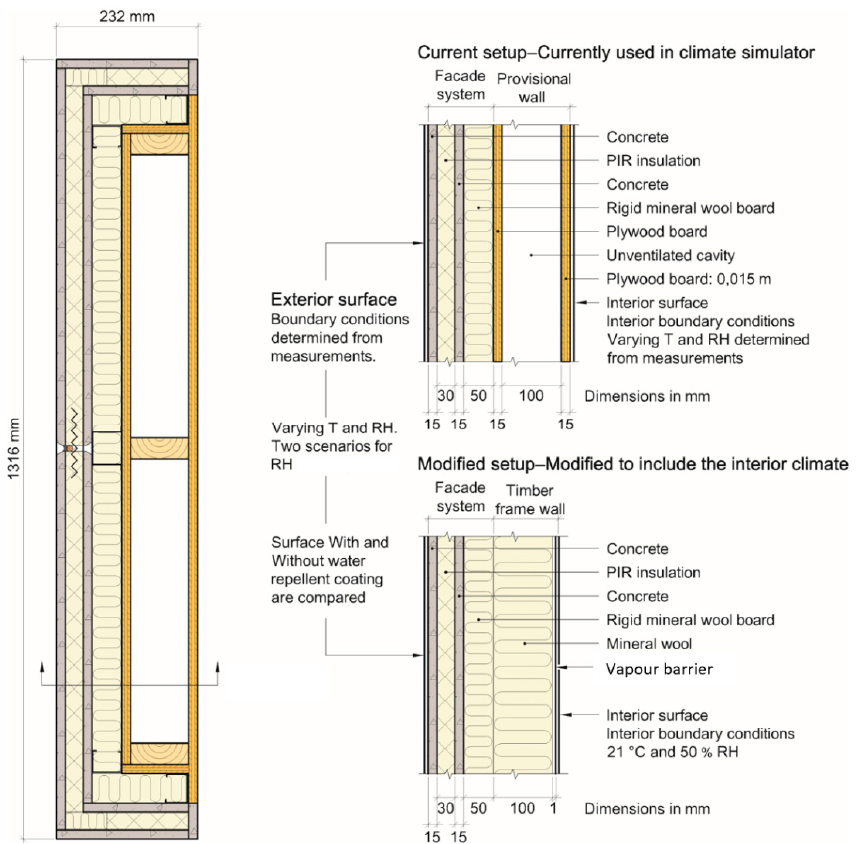
Figure 2. Test setups applied in the hygrothermal simulations. In the current setup, the façade system was erected on a provisional wall and the interior climate varied depending on the exterior exposure. In the modified setup, the provisional wall was replaced with a mineral wool board and an interior vapour barrier. The exterior boundary conditions were the same as those of the current setup, but a constant temperature and RH were set at the interior boundary.